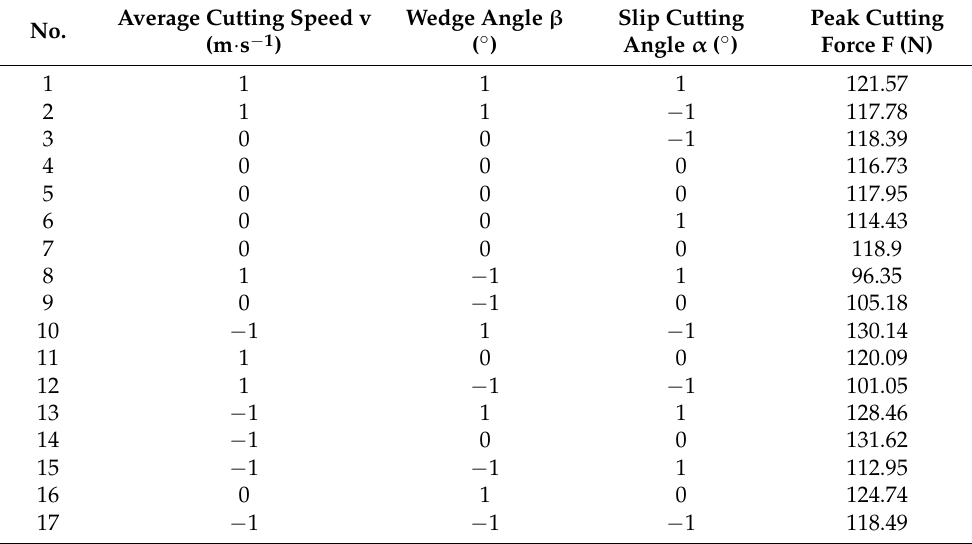
Table 4. Design Scheme and Response Results of Unsupported Cutting Test.